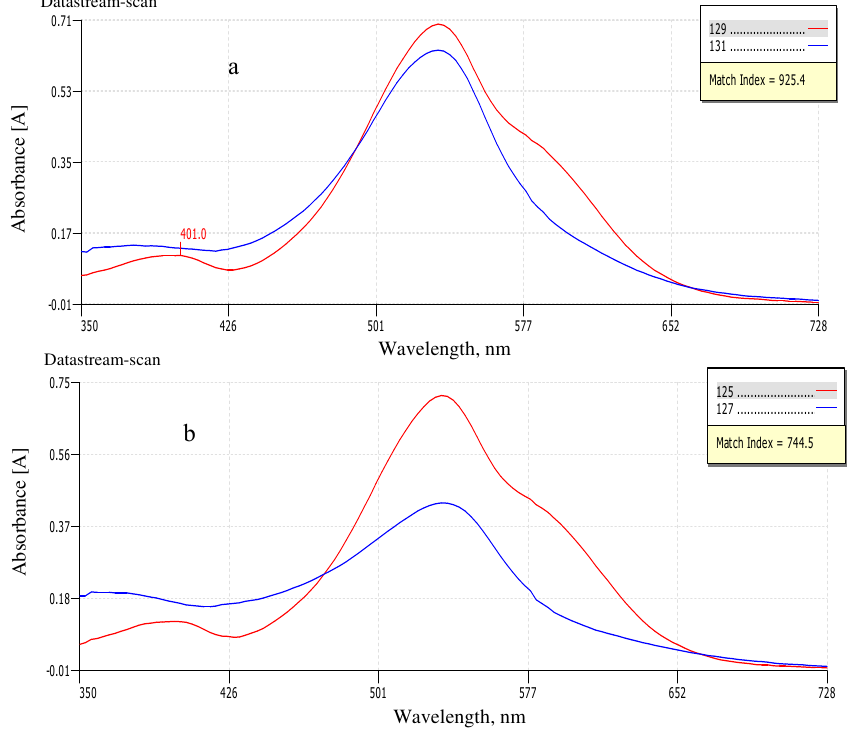
Figure 1. Absorption spectrum for the formaldehyde-safranin-BrO 3− system with time. SO , 1.2 M; safranin, 7.36 × 10 −4 M; BrO 3− 3.0 × 10 −3 M; temperature, 28 °C; Conditions: H 2 4 interval time for each scan, 0.5, 1.5 and 2.5 from initiation of the reaction. (a) in absence of formaldehyde (b) in presence of 0.4 µ g/mL of